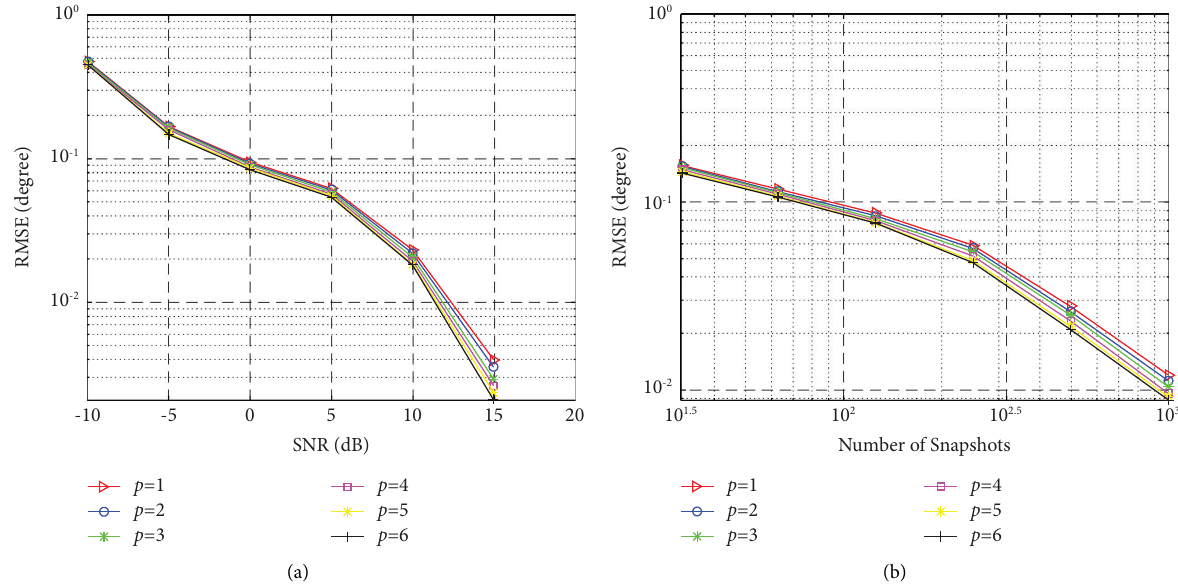
Figure 8: Performance comparison of the proposed SRTRD-p-NC-MUSIC with diferent choices of the value of p . (a) RMSEs with diferent SNRs, L � 500. (b) RMSEs with a diferent number of snapshots, SNR � 10 dB.